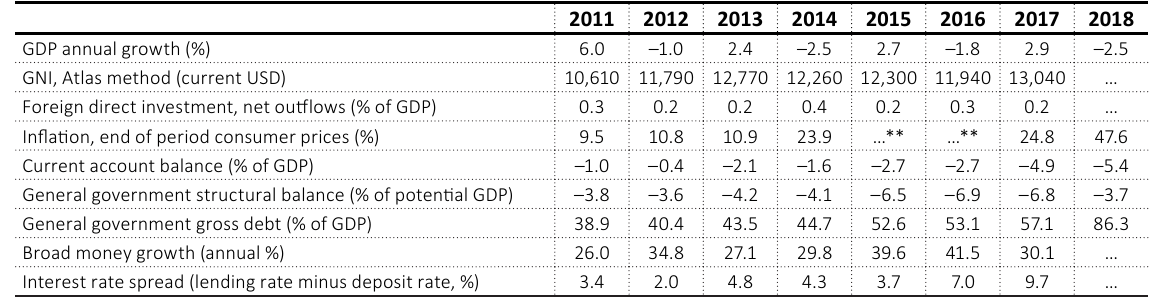
Source: World bank,